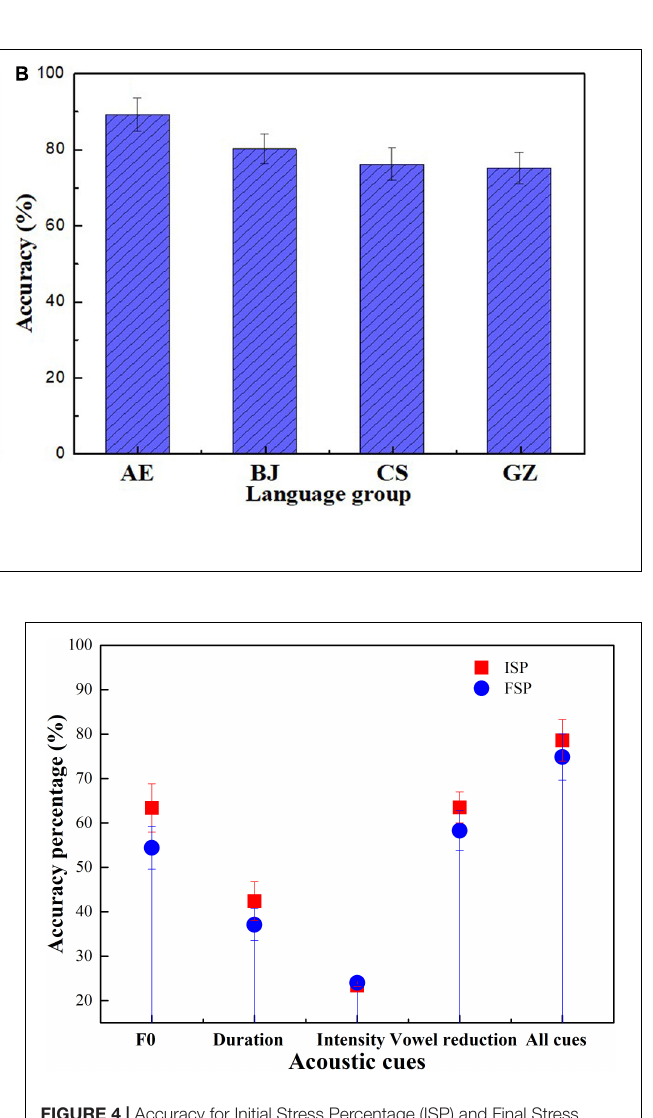
Four univariate ANOVAs were conducted for the four